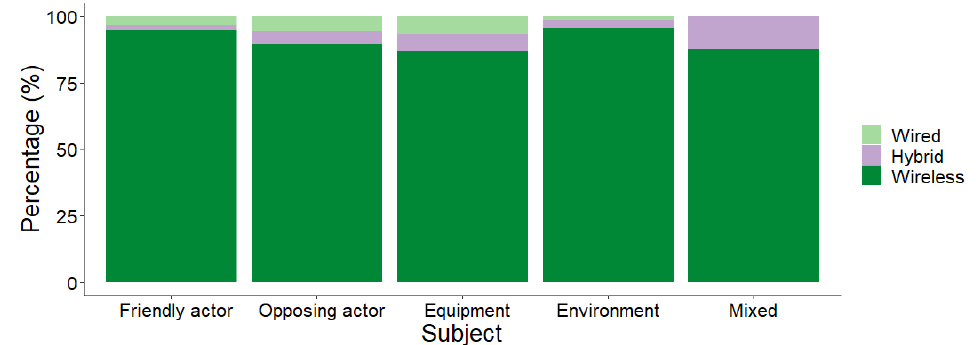
Figure 36. Deployment distribution between deployment subject and node connection